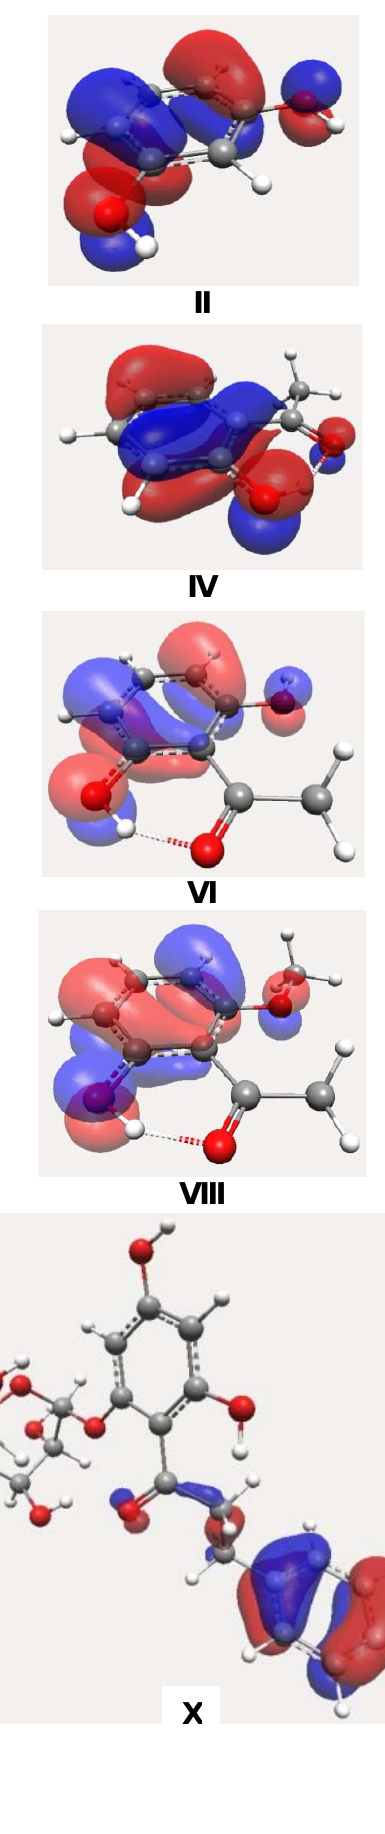
Figure 3. HOMO of dihydrochalcone-semiquinone and related